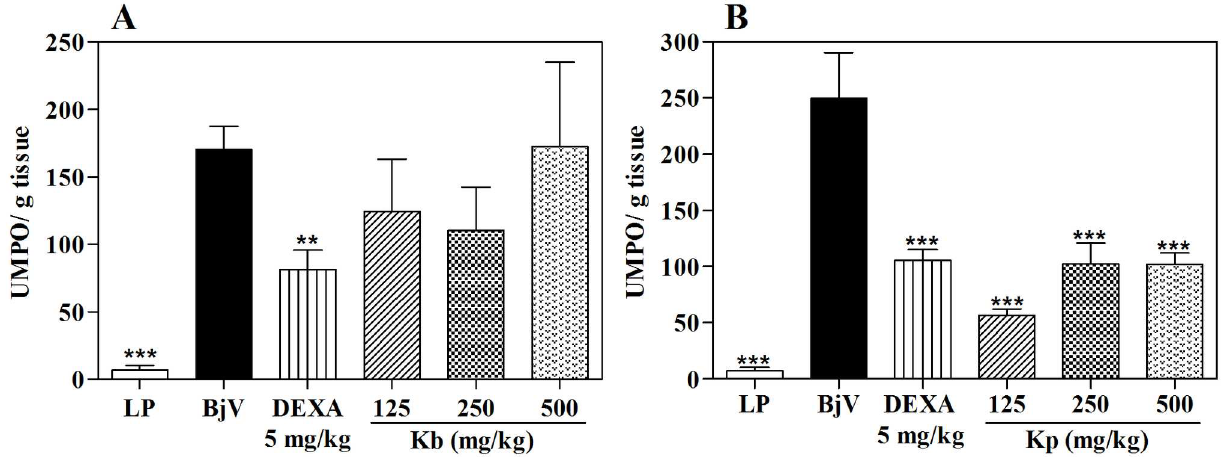
Fig 8. Effect of extracts of K . brasiliensis (Kb) (A) and K . pinnata (Kp) (B) on MPO levels in paw edema induced by B . jararaca venom (BjV) in pre-treatment protocol. LP: left paw (basal control; no injectionof venom, extract or dexamethasone). UMPO: a unit of MPO, definedas the equivalentto the consumptionof 1 μ molof hydrogen peroxideper minute. The columns represent the mean ± SEM (n = 5), ** p < 0.01 and *** p < 0.001comparedto the control group (i.pl. injectionof BjV with i.p. administration of 5% castor oil in PBS) after Tukey’s test (one-wayANOVA followedby the Tukey’s